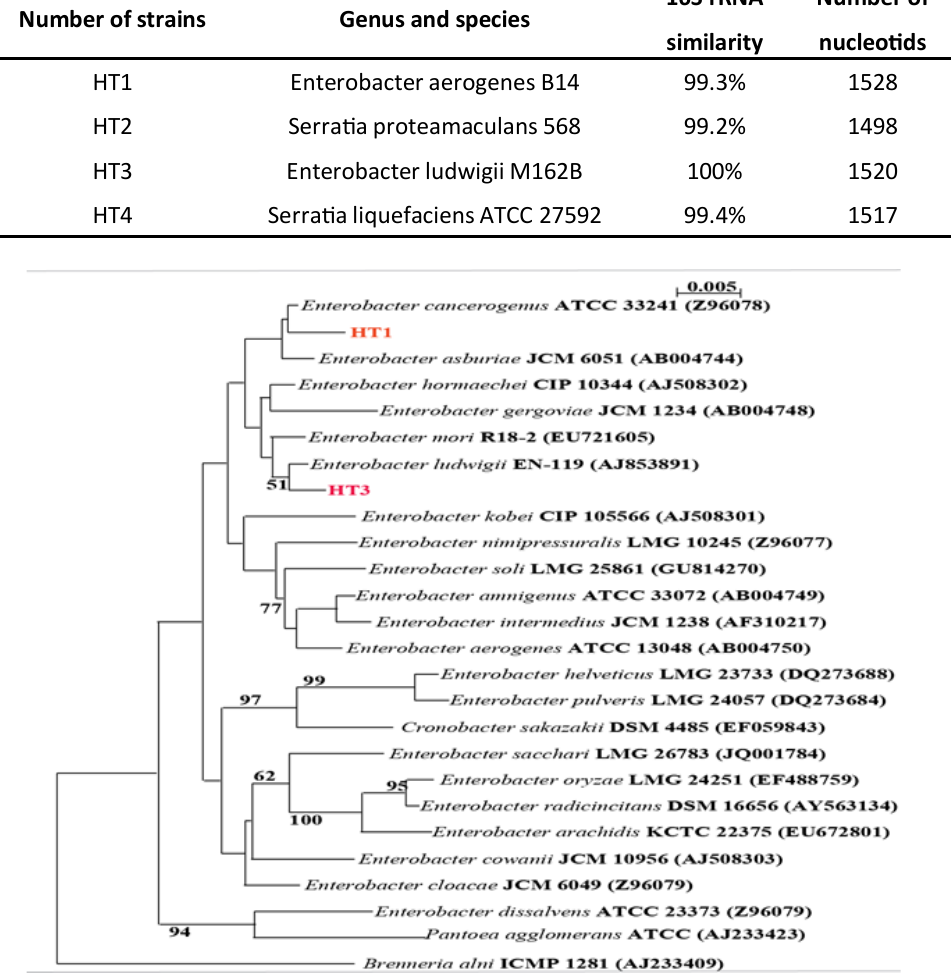
Fig. 1. Phylogenetic tree of HT1 and